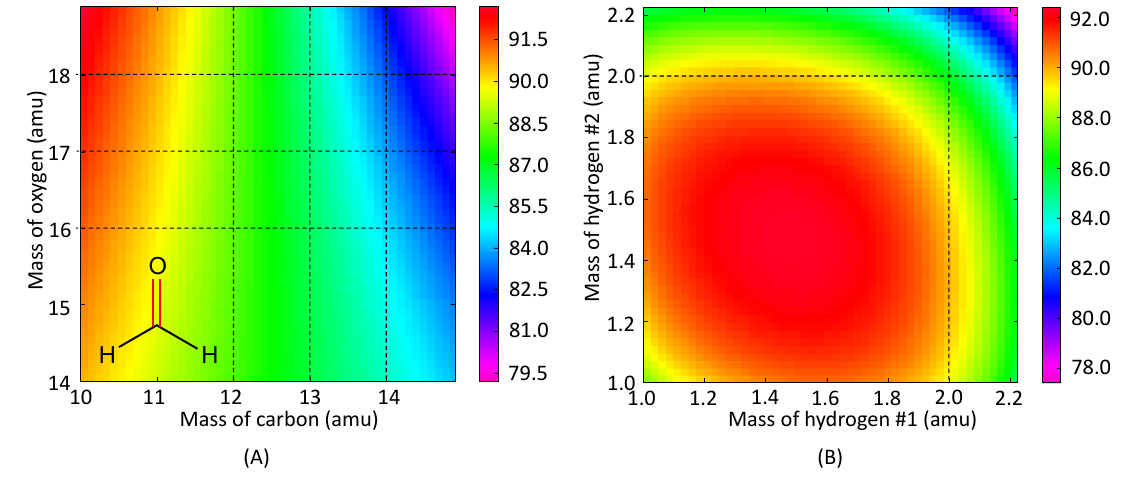
Figure 5. Performance score of formaldehyde as a function of atomic masses in ( A ) carbon and oxygen atoms and ( B ) two hydrogen atoms, respectively. Red is for higher score while purple is for the lower score. The dashed lines indicate the atomic mass values for